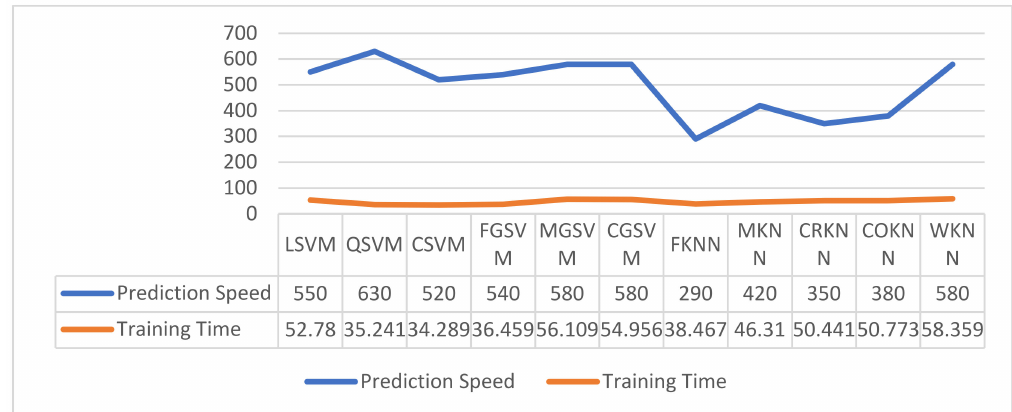
Figure 12. Proposed model training time (s) and prediction speed (obs/s) on mixed views of VIPeR dataset utilizing 1000-feature subset.